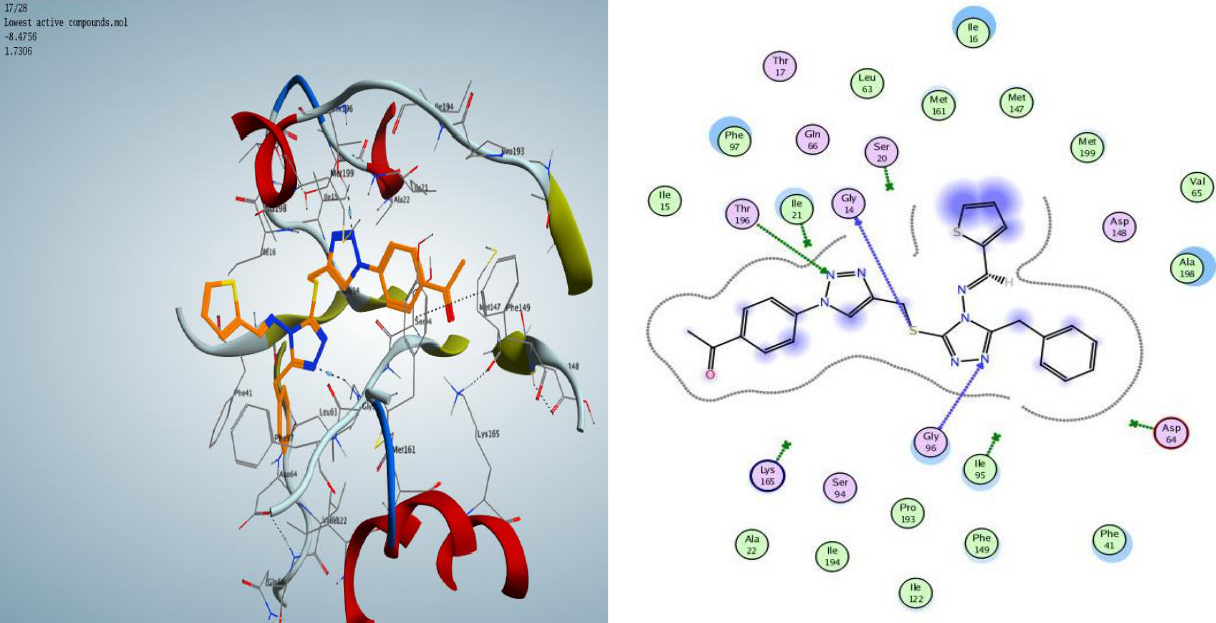
Figure 15. Docking and binding pattern of 7b into inhA active site (PDB ID: 4TRO) in 2D (right panel) and 3D (left panel).